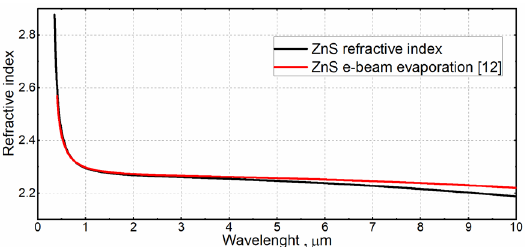
Figure 4. The black curve is the obtained refractive index dispersion of a ZnS monolayer by IBS method; the red curve is ZnS dispersion obtained in [12] by e-beam evaporation (IAD).